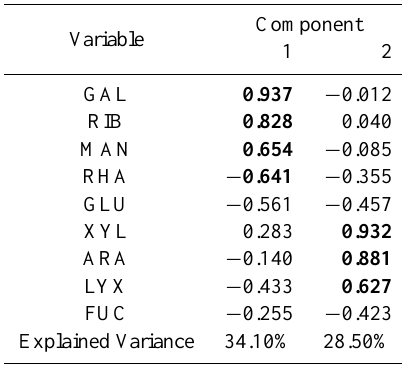
Table 5. Varimax rotated factor matrix for the whole neutral sugar